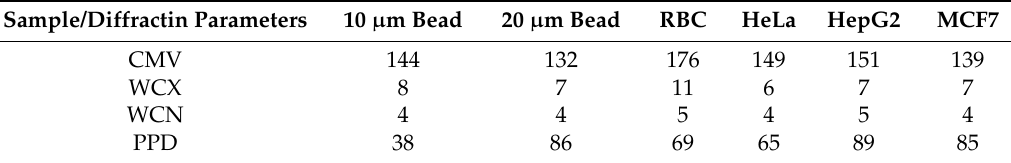
Table 1. Statistical average of 10 samples for the diffraction